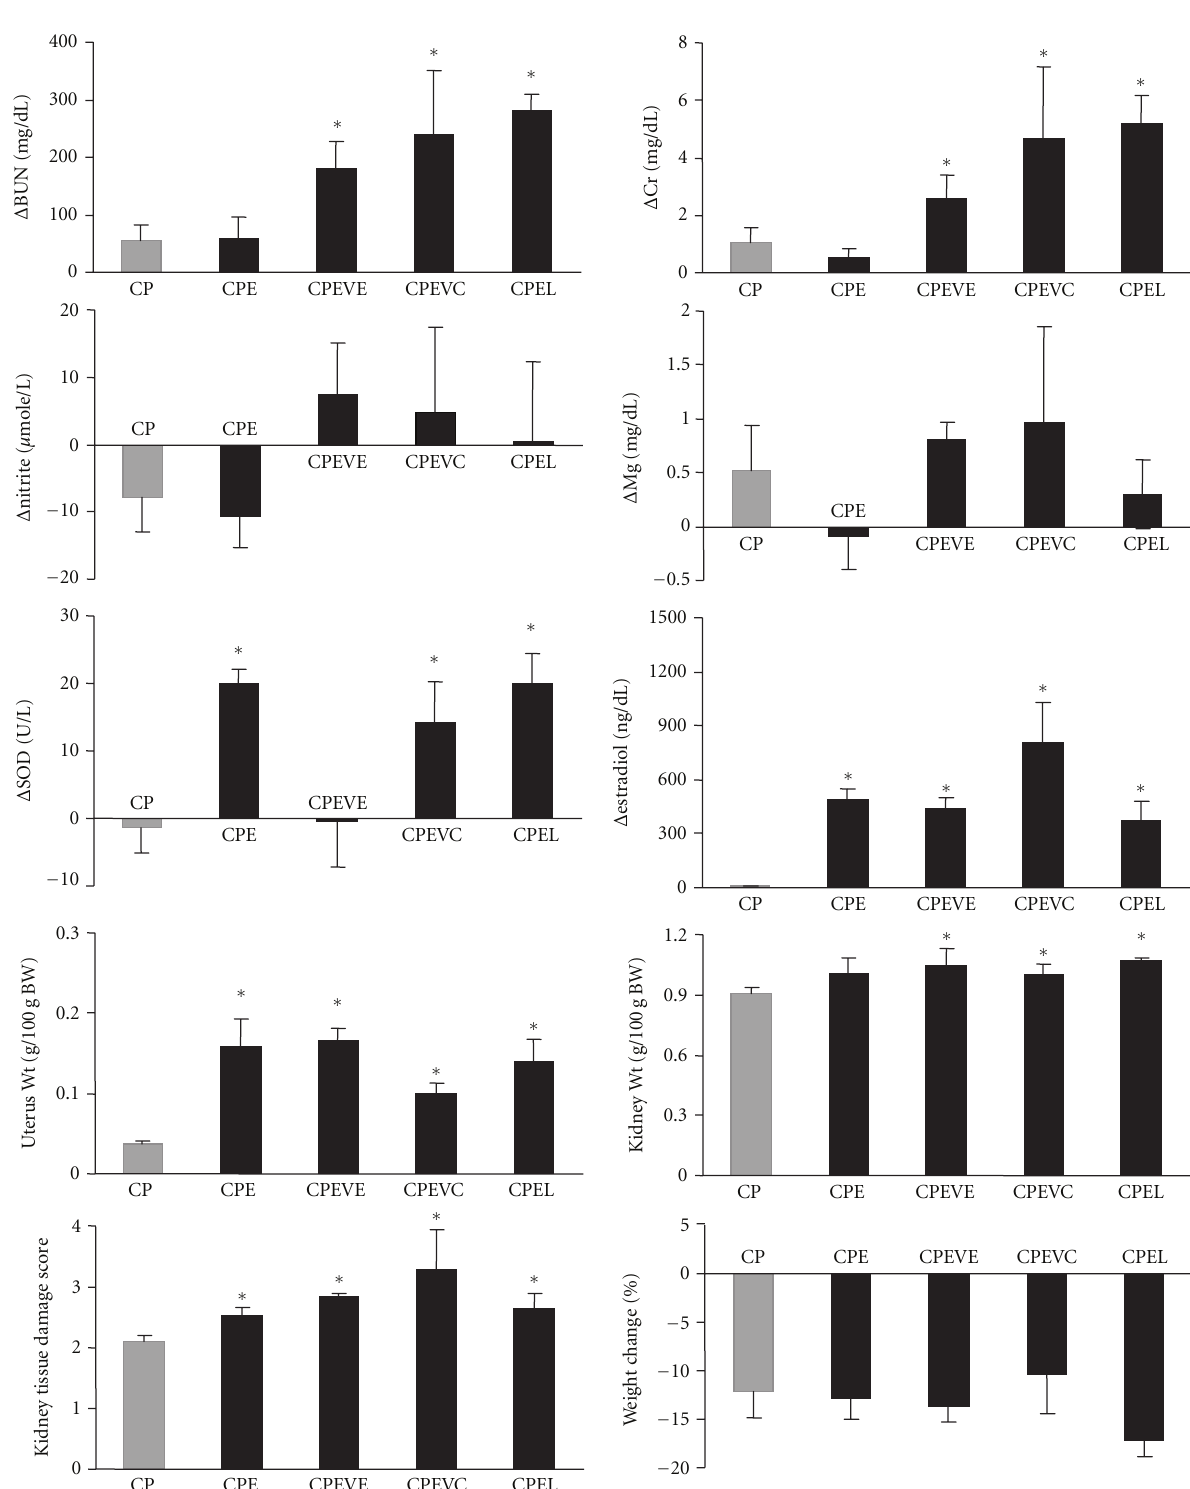
− Figure 2: Serum di ff erence levels (one week after CP administration − before CP administration; Δ ) of BUN, Cr, Mg, SOD, estradiol, and nitrite; the kidney and the uterus weights; and KTDS in estradiol and CP, estradiol plus vitamin E and CP, estradiol plus vitamin C and CP, estradiol plus losartan and CP-treated ovariectomized groups (group 1–4) compared with ovariectomized rats treated with CP alone (positive control group). CP, CPE, CPEVE, CPEVC, and CPEL on the horizontal axes stand for groups treated with CP alone (group 5), estradiol and CP (group1), estradiol plus vitamin E and CP (group 2), estradiol plus vitamin C and CP (group 3), and estradiol plus losartan and CP (group 4), respectively. The star indicates significant di ff erence ( P < 0 . 05) when compared with the positive control